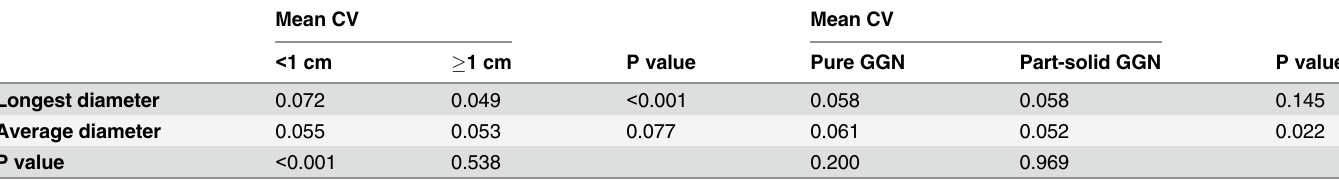
Table 5. Subgroup analysis according to nodule size and type in situation 2 (replaced reader